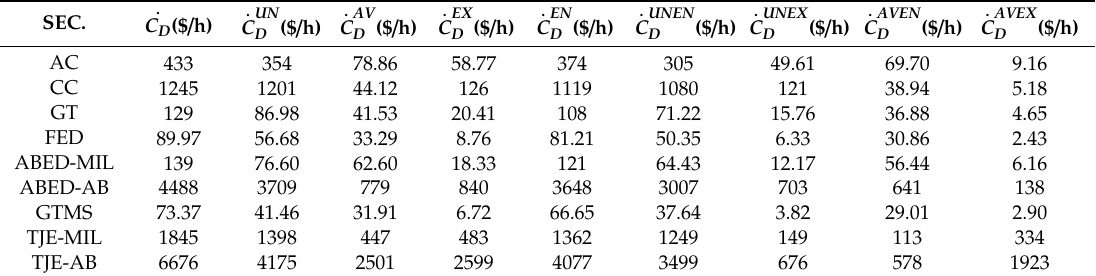
Table 17. Results for advanced exergy destruction costs of TJE and sections for H 2